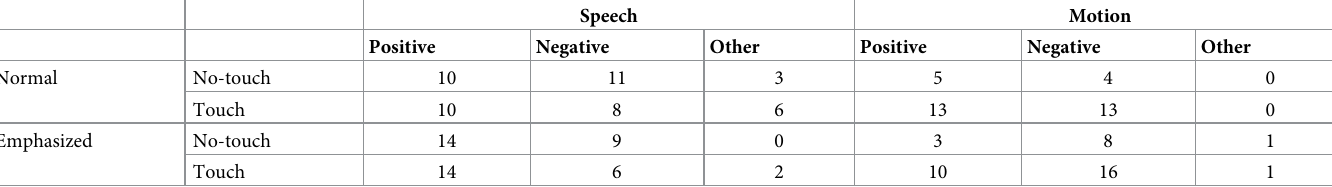
Table 1. Coding of free-description